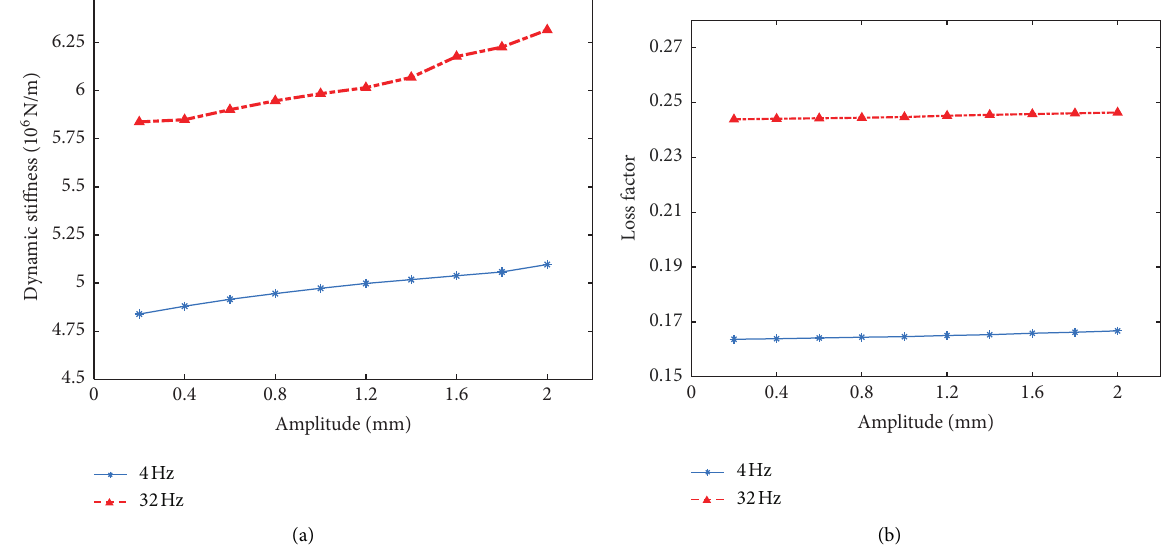
Figure 24: The influence of amplitude at different frequencies on dynamic characteristics of shaft damping ring. (a) The influence of amplitude on dynamic stiffness. (b) The influence of amplitude on loss